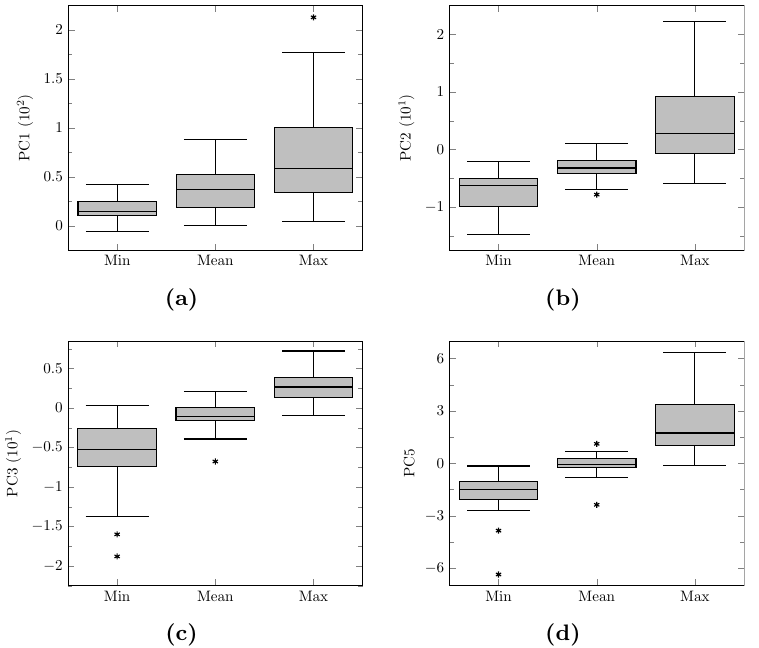
Figure A5. Distribution of the minimum, maximum, and mean PC values within the BTV in Table A5 for lesions with a non-zero BTV summarized by means of boxplots (horizontal line: median, box: interquartile range, whiskers: ± 1.5 interquartile range, *: outliers). ( a ): PC1. ( b ): PC2. ( c ): PC3. ( d ):